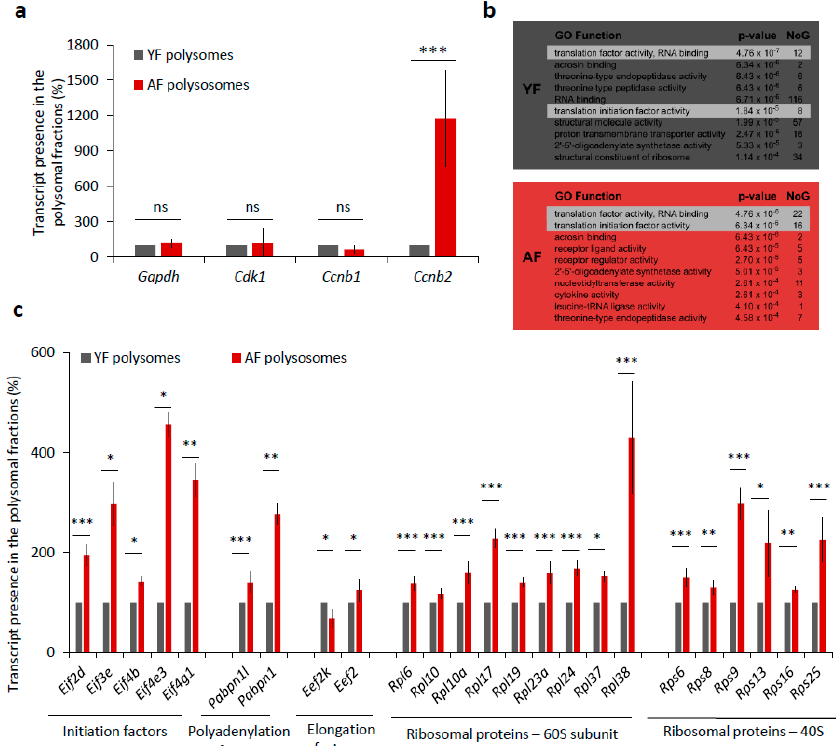
Figure 5. Translation of a number of translational factor components is increased in the oocytes from aged females. ( a ) mRNA abundance of MPF components, Cdk1 and Cyclins B as well as Gapdh used as the control in the polyribosomal fractions. Percentage of reads from RNA-Seq. See Figure S3a for quantification of total RNA in oocytes from YF and AF groups. Three independent experimental datasets from biologically different samples. Values obtained for the YF group were set as 100%. Data columns represent mean; error bars, ± SEM; ns non-significant; *** p < 0.001; Student’s t- test. ( b ) Top 10 most enriched GO Function categories in polysome-bound mRNAs in YF (grey) and AF (red) oocytes determined by Gorilla. NoG (Number of Genes) denotes the number of genes in enriched categories. Highlighted lines represent translational functional categories. ( c ) Translational regulation of mRNA coding for different translational factors from polysomal fractions of YF and AF oocytes. Values obtained for the YF group were set as 100%. Data represent mean ± SEM; * p < 0.05; ** p < 0.01; *** p < 0.001; Student’s t- test.